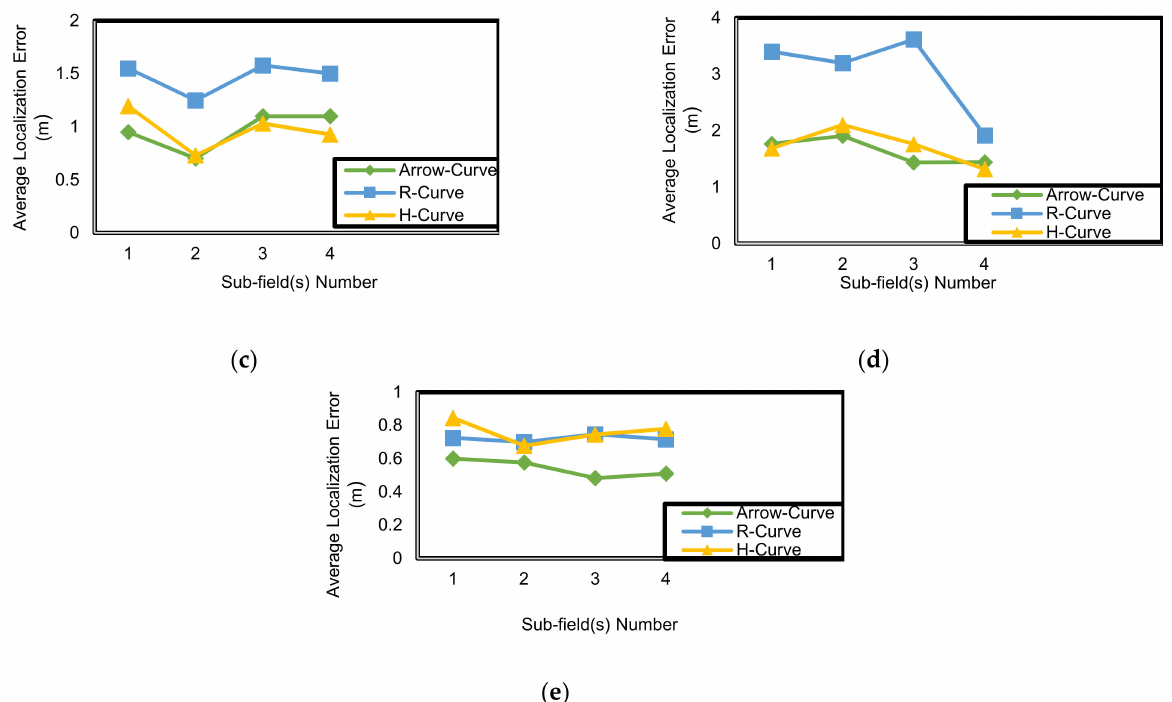
Figure 20. Average localization error (m) corresponding to sub-field (S) number at resolution (L) in indoor environment: ( a ) L = 7; ( b ) L = 6; ( c ) L = 5; ( d ) L = 4; ( e ) L = 3.